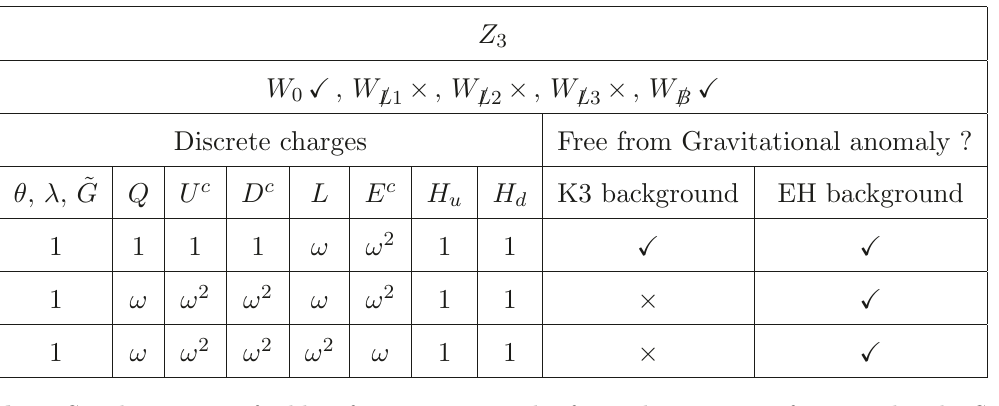
Table 4 . See the caption of table 2 for notations, and refer to the main text for more details. Solu- tions which can be obtained by the replacements ω → ω 2 and ω 2 → ω are removed from the table.